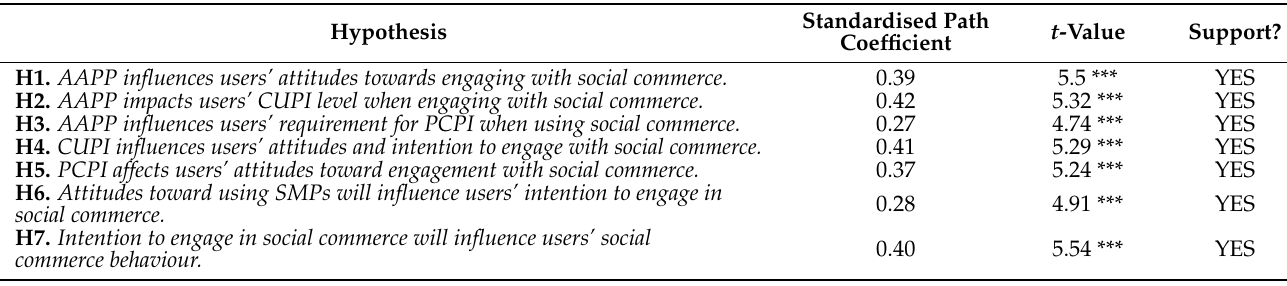
Table 5. Path coefficients and t -values for full sample.